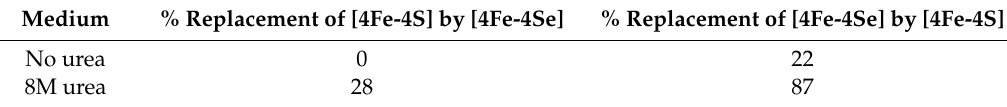
Table 1. Iron-sulfur stability in 2[4Fe-4S] ferredoxin from Clostridium pasteurianum 1 .